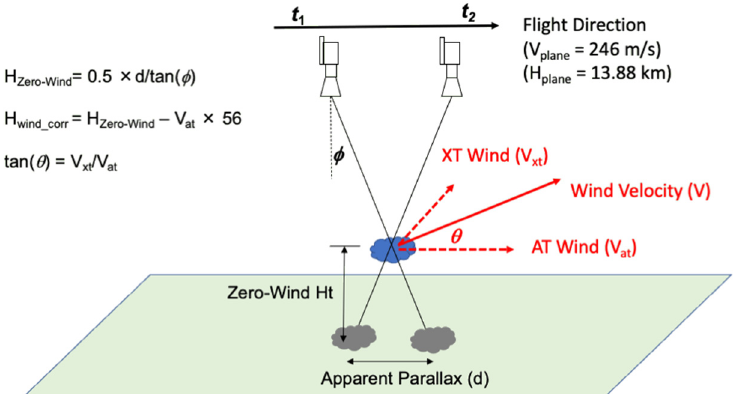
Figure 13. Geometry of stereo calculation to calculate wind-corrected height. The factor 56 (m per m/s) is the time elapsed between observations.